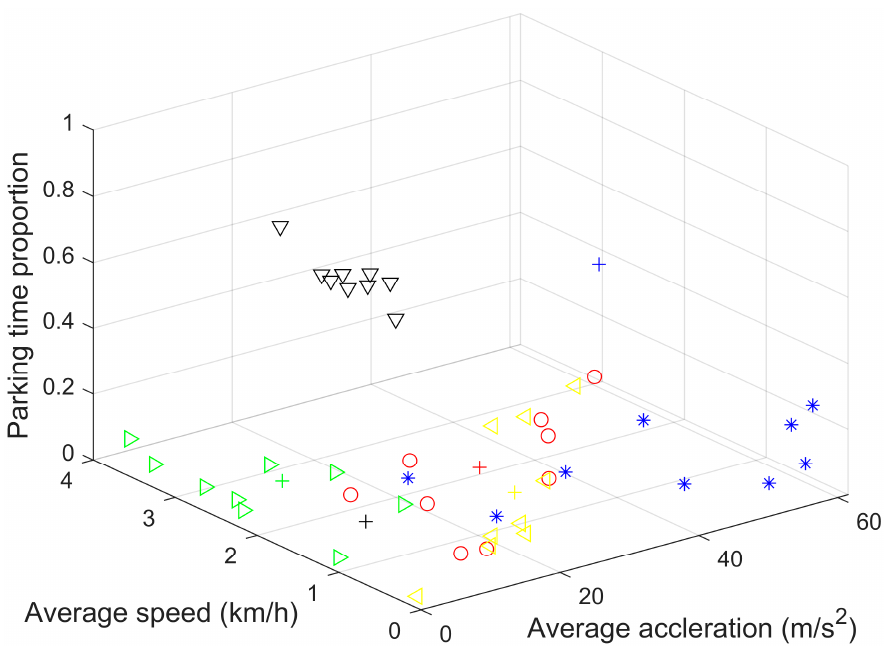
Figure 6. Classi fi cation results of the K-means algorithm. Figure 6. Classification results of the K-means algorithm.